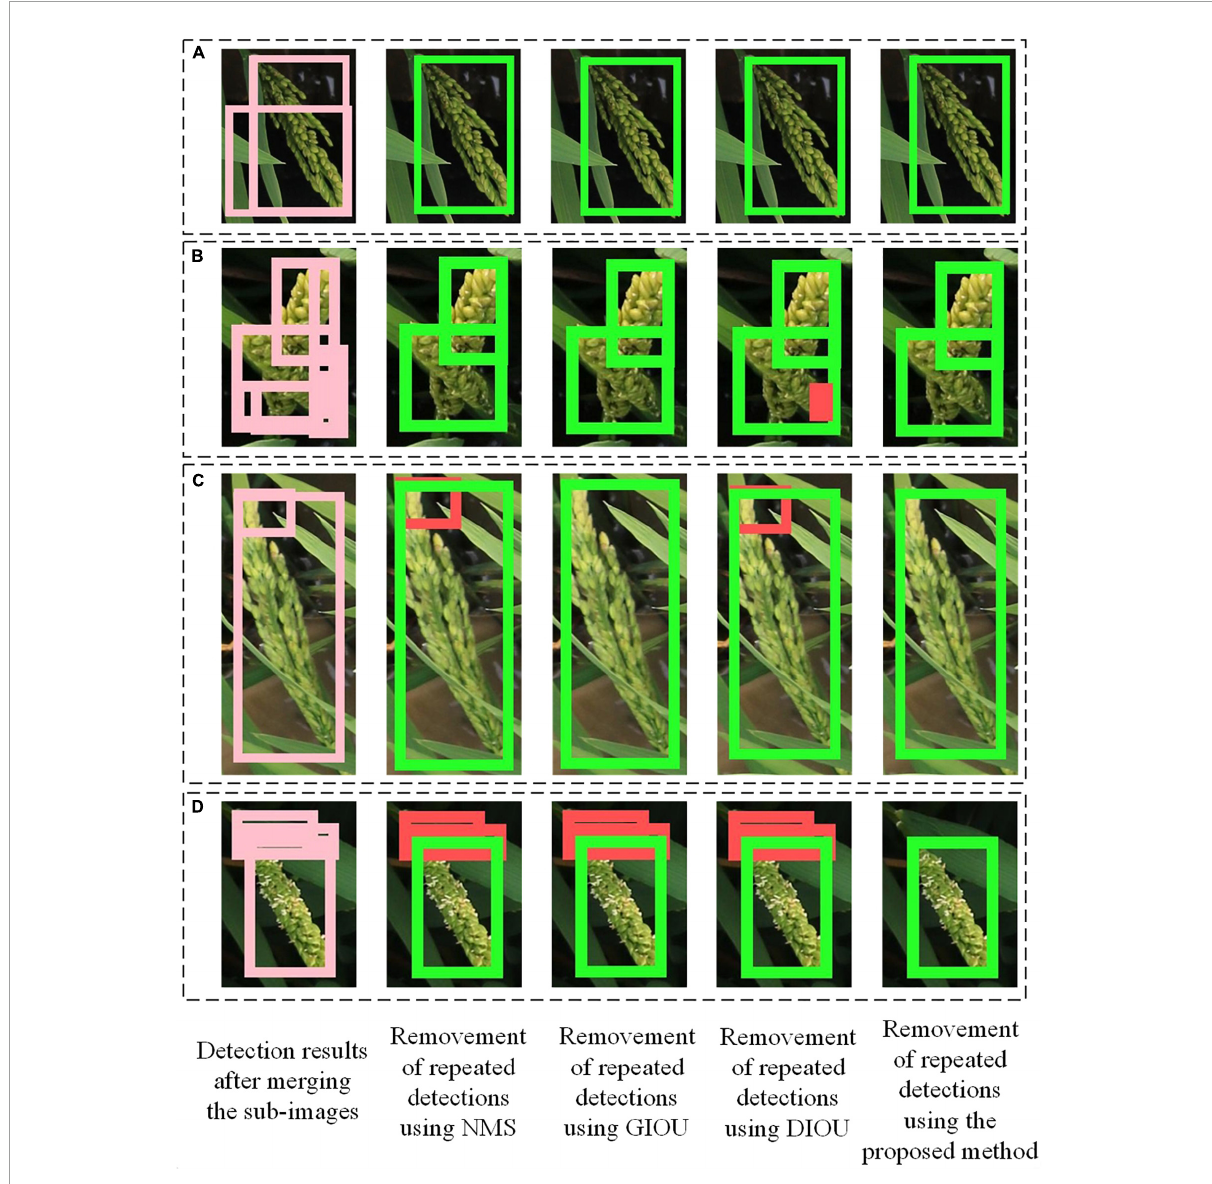
FIGURE7 Detection results of rice image processed by the proposed method and other methods. (A) The areas of the overlapping boxes were similar. (B–D) The areas of the overlapping boxes varied greatly. In the detection results, green boxes are correct bounding boxes and red boxes are FP